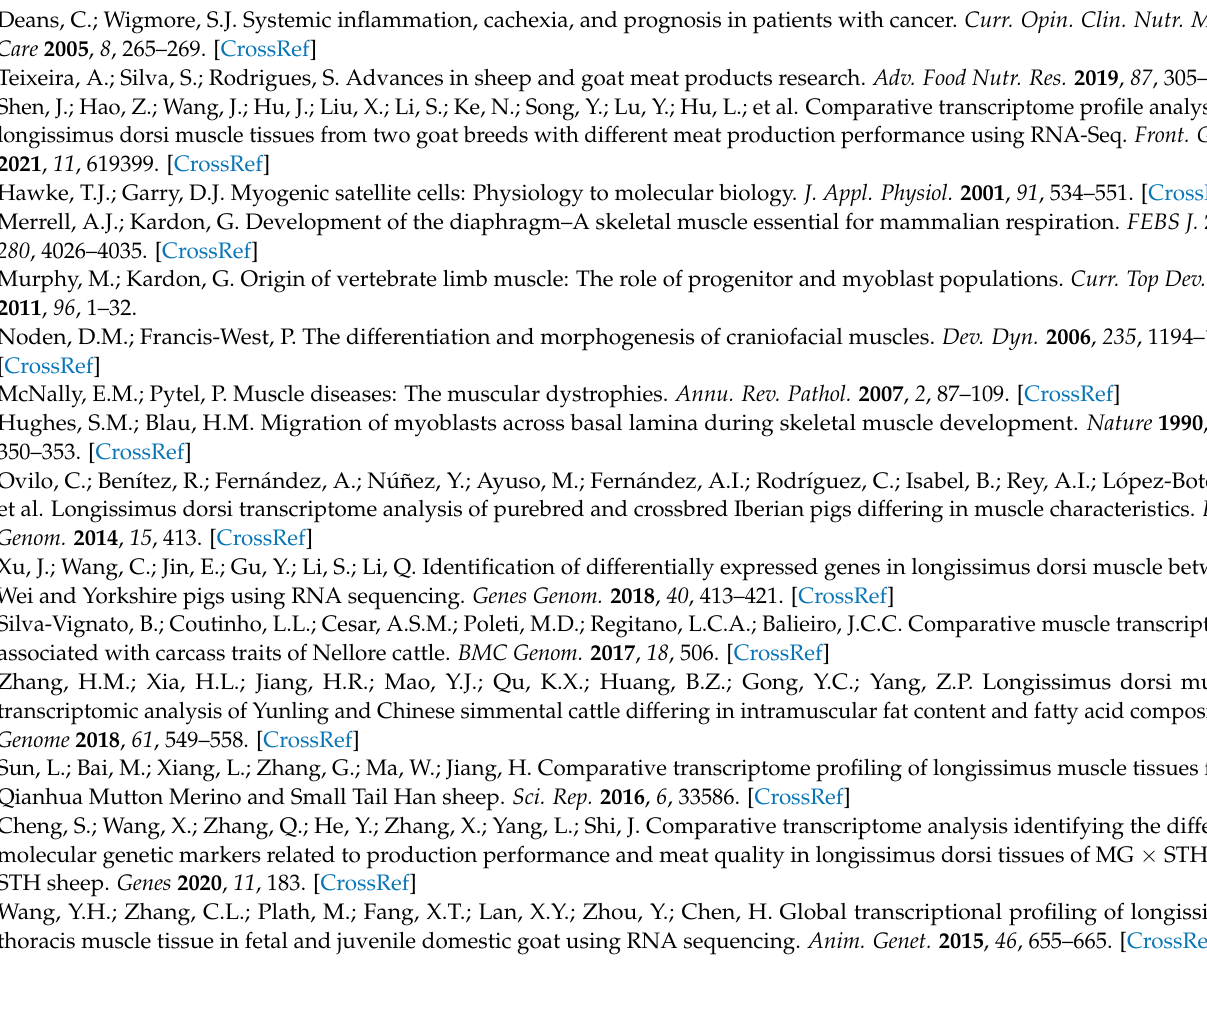
Table S2: Summary of the RNA-Seq dataset; Supplementary Table S3: The details of mRNAs between groups mon1 and mon9; Supplementary Table S4: Differentially expressed